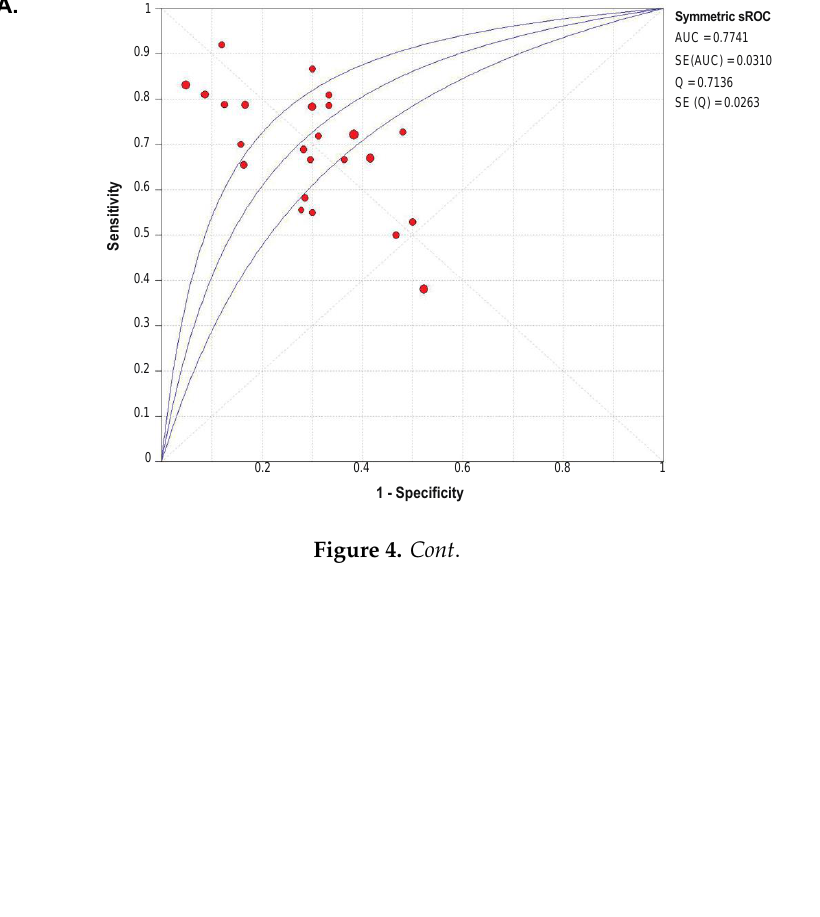
Figure 4. Cruz-Tapias P, et al